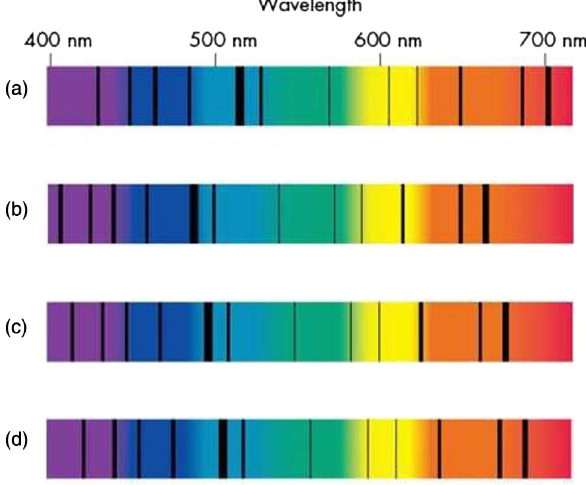
FIG. 6. Spectra: Distance of galaxies. Following open-ended question was asked: These are spectra that were obtained from four different galaxies. Do you think with these spectra images you can arrange them by distances from nearest to furthest from us? If so, please do so and explain why you arranged them in such a way. If not, please explain why you can not do with these images.